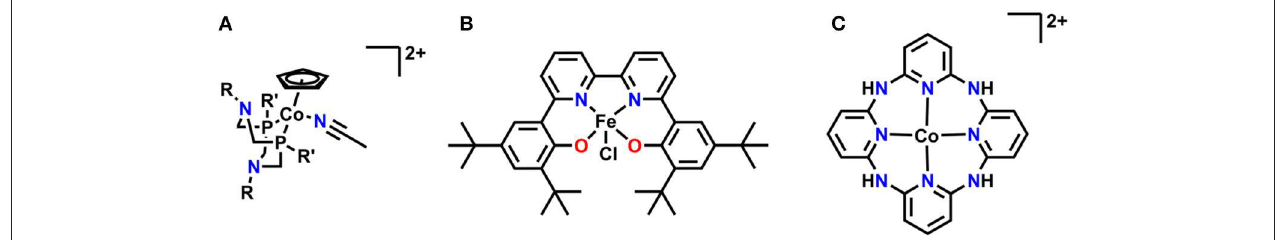
FIGURE 14 | (A) Co(Cp)(P 2 N 2 ) utilizing pendent tertiary amines for reduction of CO 2 to formate. (B) Fe( tbu dhbpy)CI is protonated at the Fe-coordinating O atoms upon reduction and reduces CO 2 to formate. (C) Macrocyclic–aminopyridyl complex which reduces CO 2 to